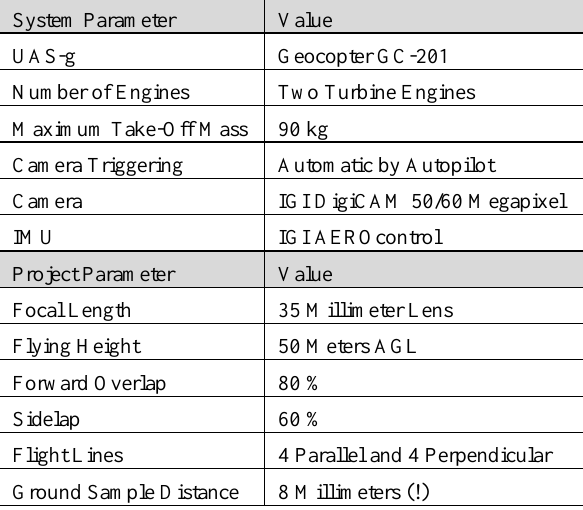
Table 1. System and Project Specs